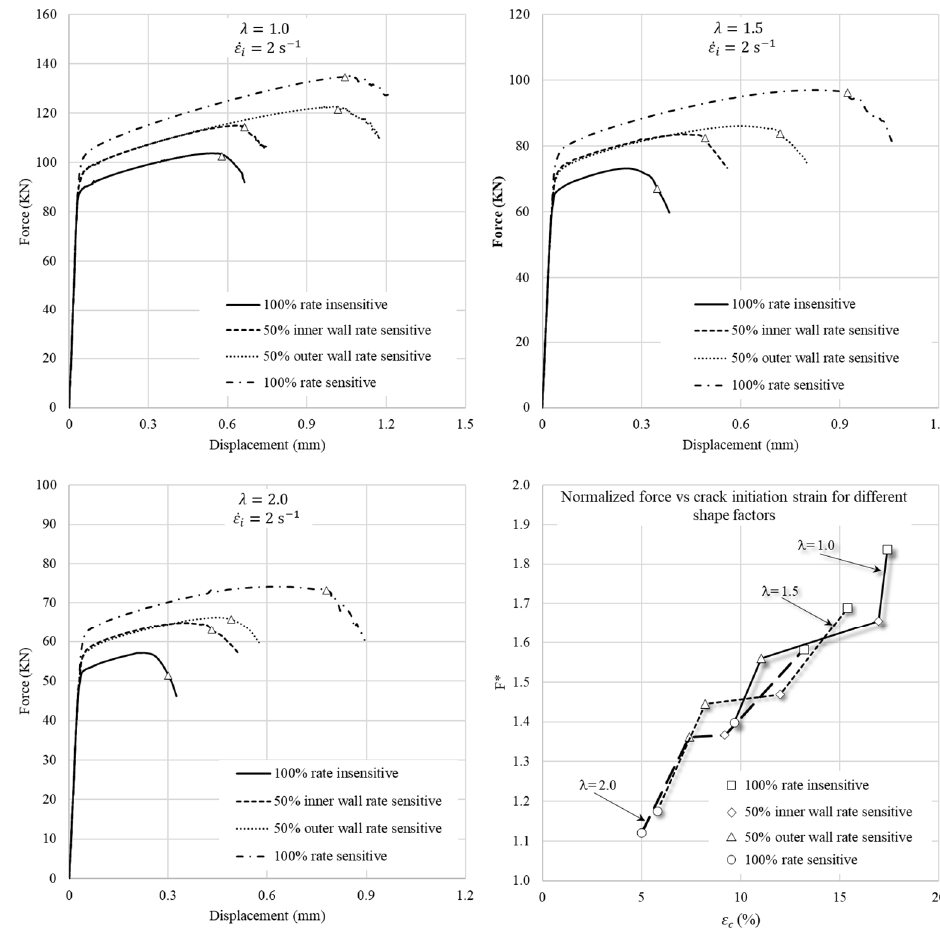
Figure 15. Effect of shape factor on fracture parameters.